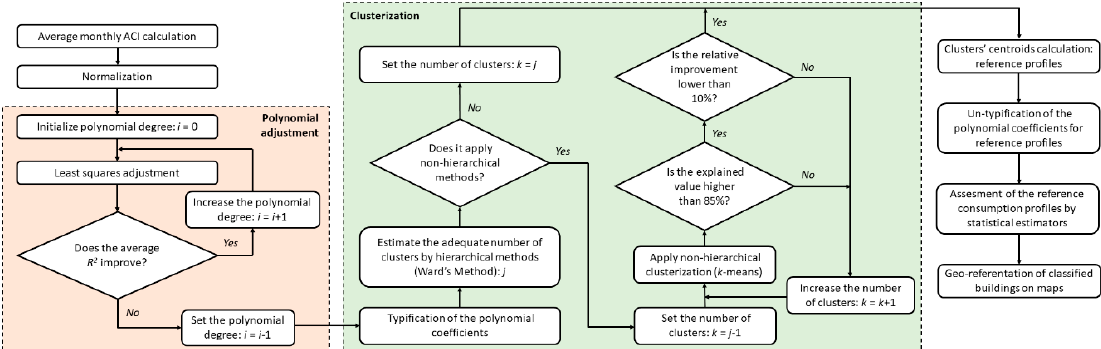
Figure 2. Flow-chart for clusterization and identification of reference consumption